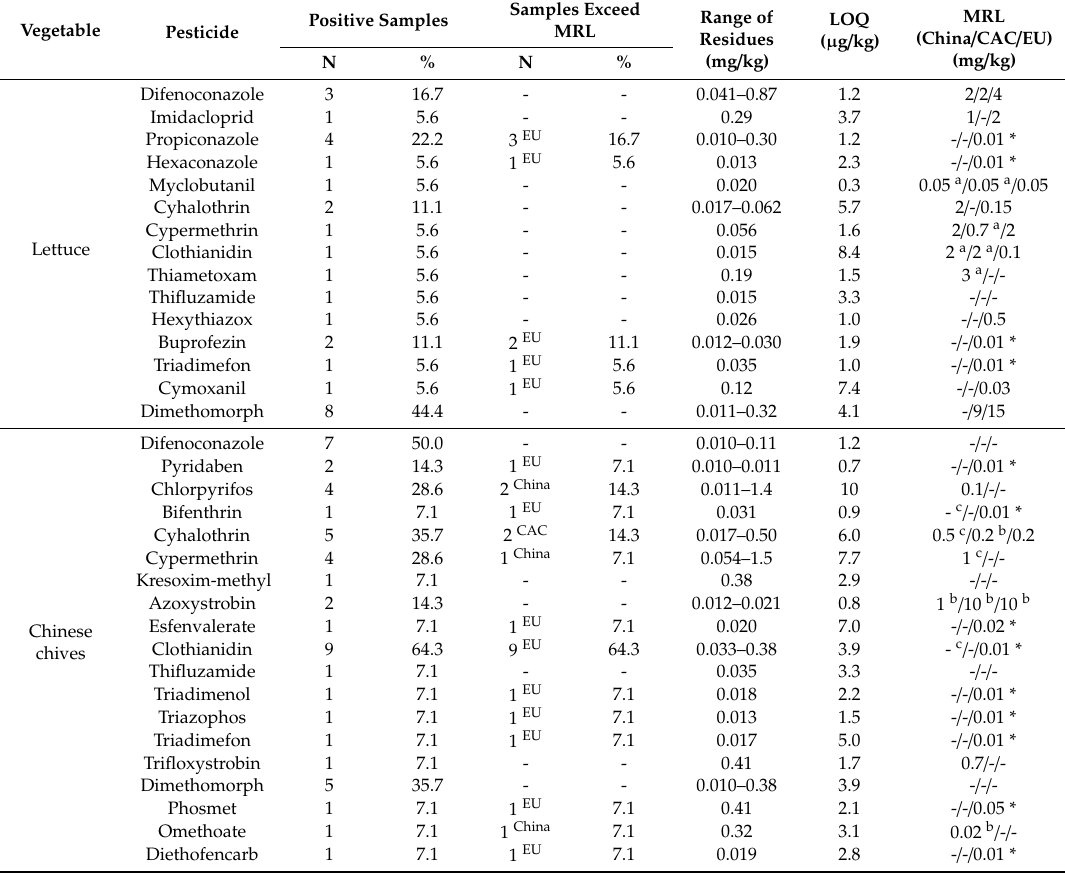
Table 1. Pesticide residues in real lettuce and Chinese chives